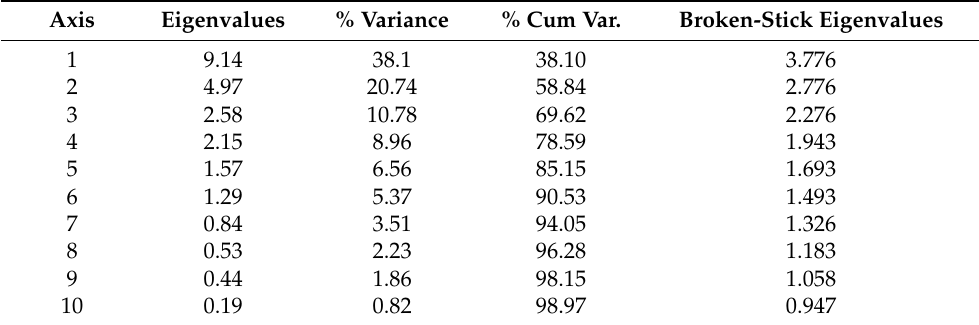
PCA-ordination explained 98.97% of the cumulative variance between metal bio- concentration, accumulation, and translocation factors of metals with soil spatial and textural properties at different abandoned habitats in Khyber Pakhtunkhwa,